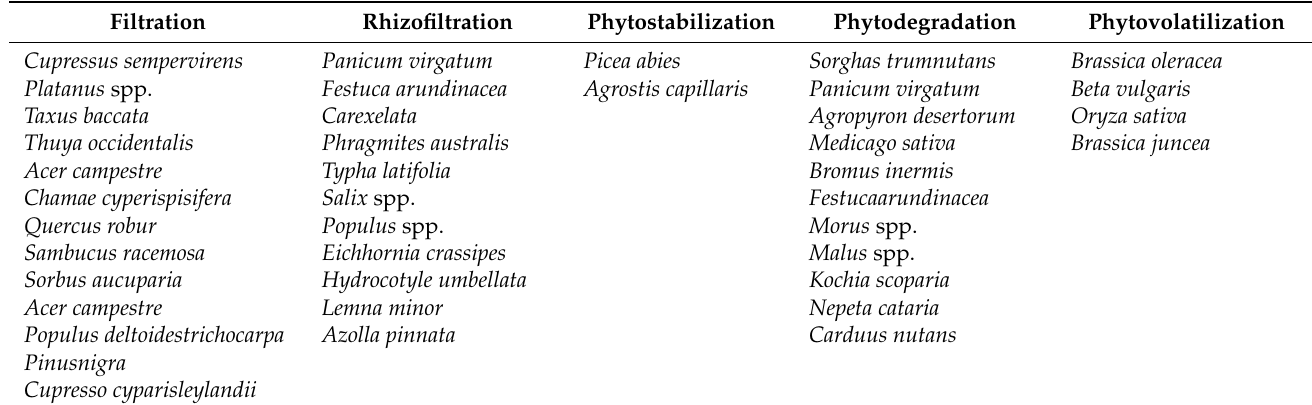
Table 1. Plants useful for the remediation of polluted sites (Adapted from [36]).